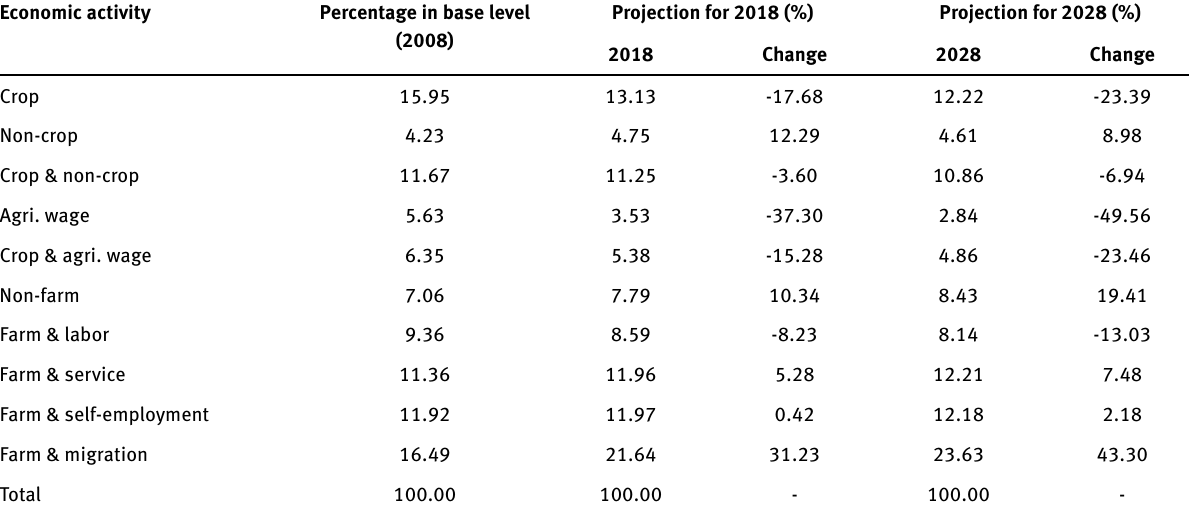
Table 3: Projected distribution of rural economic activity in 2018 and 2028 Economic